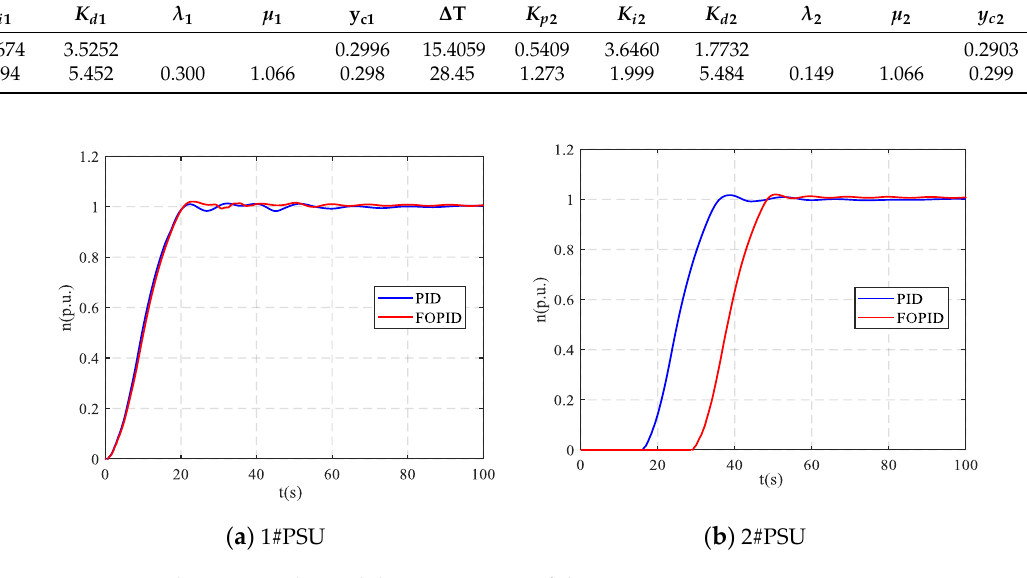
Figure 14. The rotational speed dynamic curves of the two PSUs.